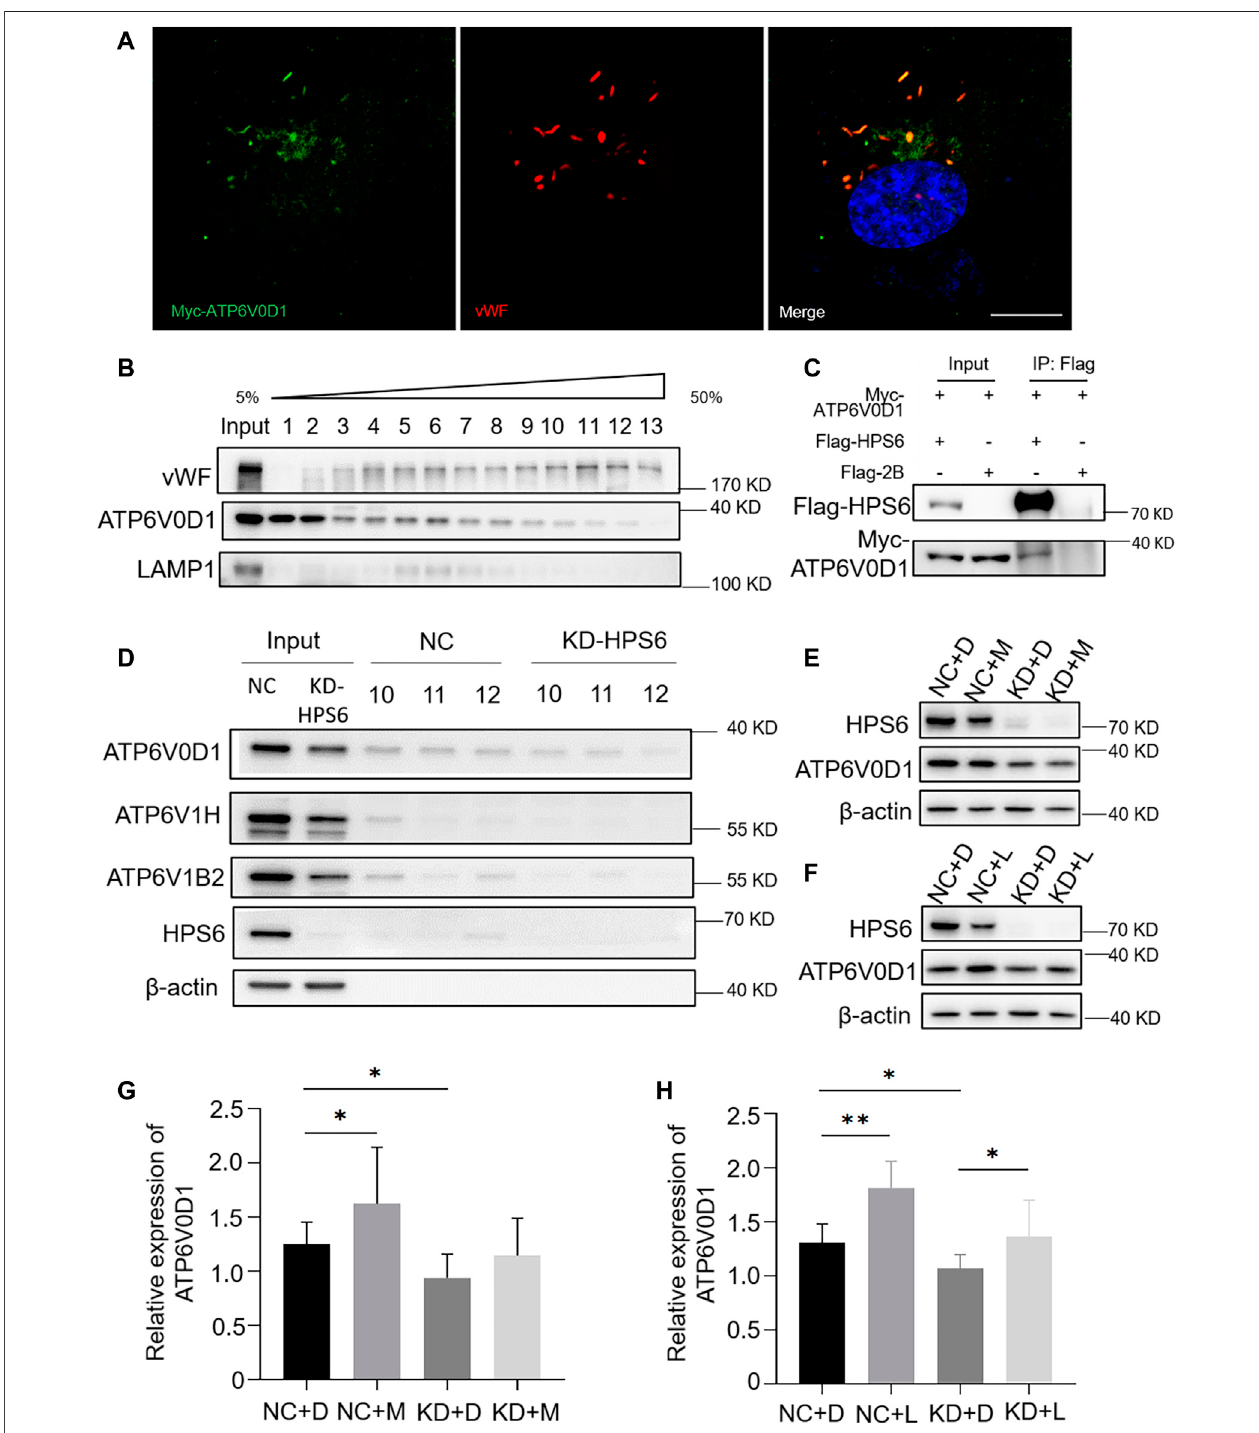
FIGURE 5 | HPS6 interacts with ATP6V0D1 and mediates its traf fi cking to the Weibel – Palade body (WPB). ( A ) Immuno fl uorescence images of Myc-ATP6V0D1 plasmid-transfected human umbilical vein endothelial cells (HUVECs) labeled against Myc (green), vWF (red), and nucleus (DAPI, blue). Scale bar, 10 μ m. ( B ) Separation oforganellesandproteinsbyOptiprepdensitygradient.The fi nalorganellesandproteinpelletswereplacedonto50 – 5%sucrosegradientlayersandthencentrifugedfor 30,000 rpm for 16 h at 4 ° C. A total of 13 fractions were collected from the top to the bottom of the gradient for further Western blotting experiments to test the distribution of vWF and ATP6V0D1. ( C ) A total of 293 T cells were transfected with Flag-HPS6 and Myc-ATP6V0D1 plasmids, and the cell lysates were co- immunoprecipitatedbyanti-FlagM2af fi nitygel.WesternblottinganalysisofdetectionofFlagandMycbands.( D )NCandHPS6siRNAweretransfectedintotwogroups